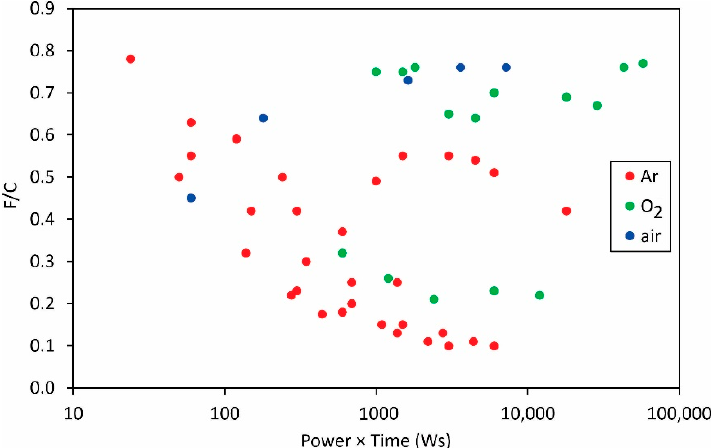
Figure 12. The F/C ratio versus the product of the reported discharge power and treatment time.